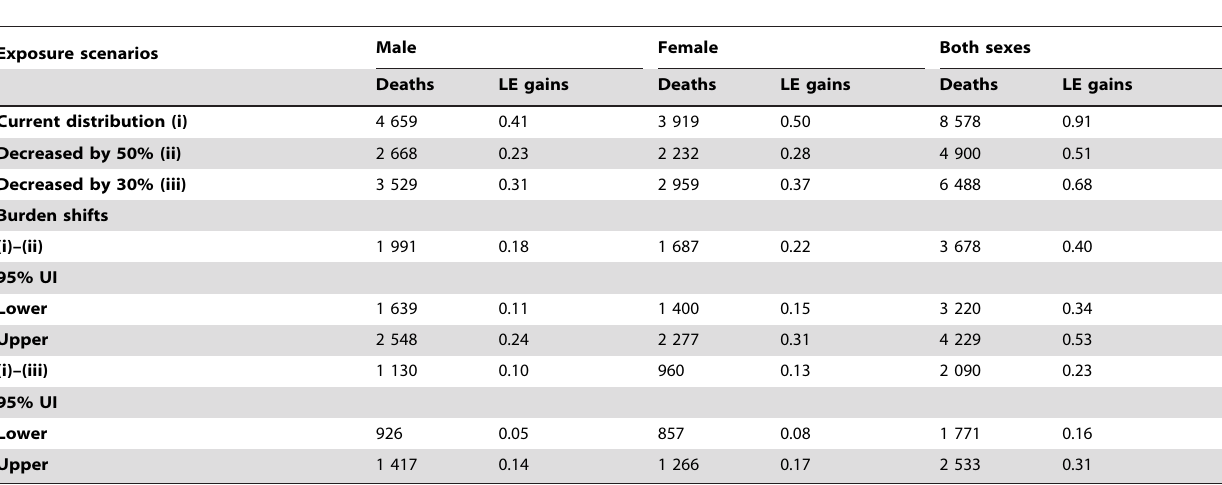
Table 4. LE shifts at different counterfactual scenarios of IPA by sex comparing with current distribution in 2010, Jiangxi province of